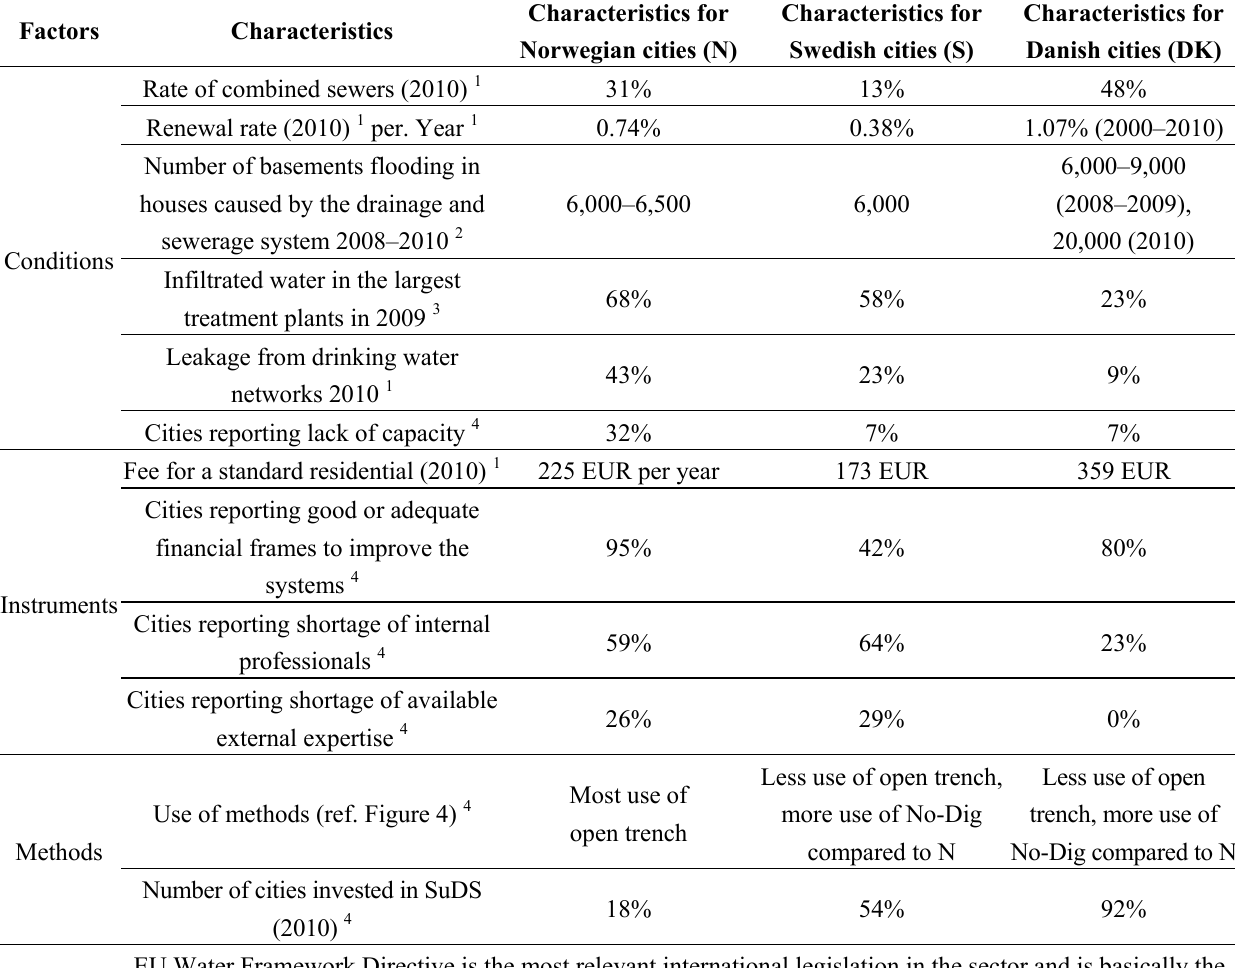
Table 1. Comparison of factors that may affect flooding and